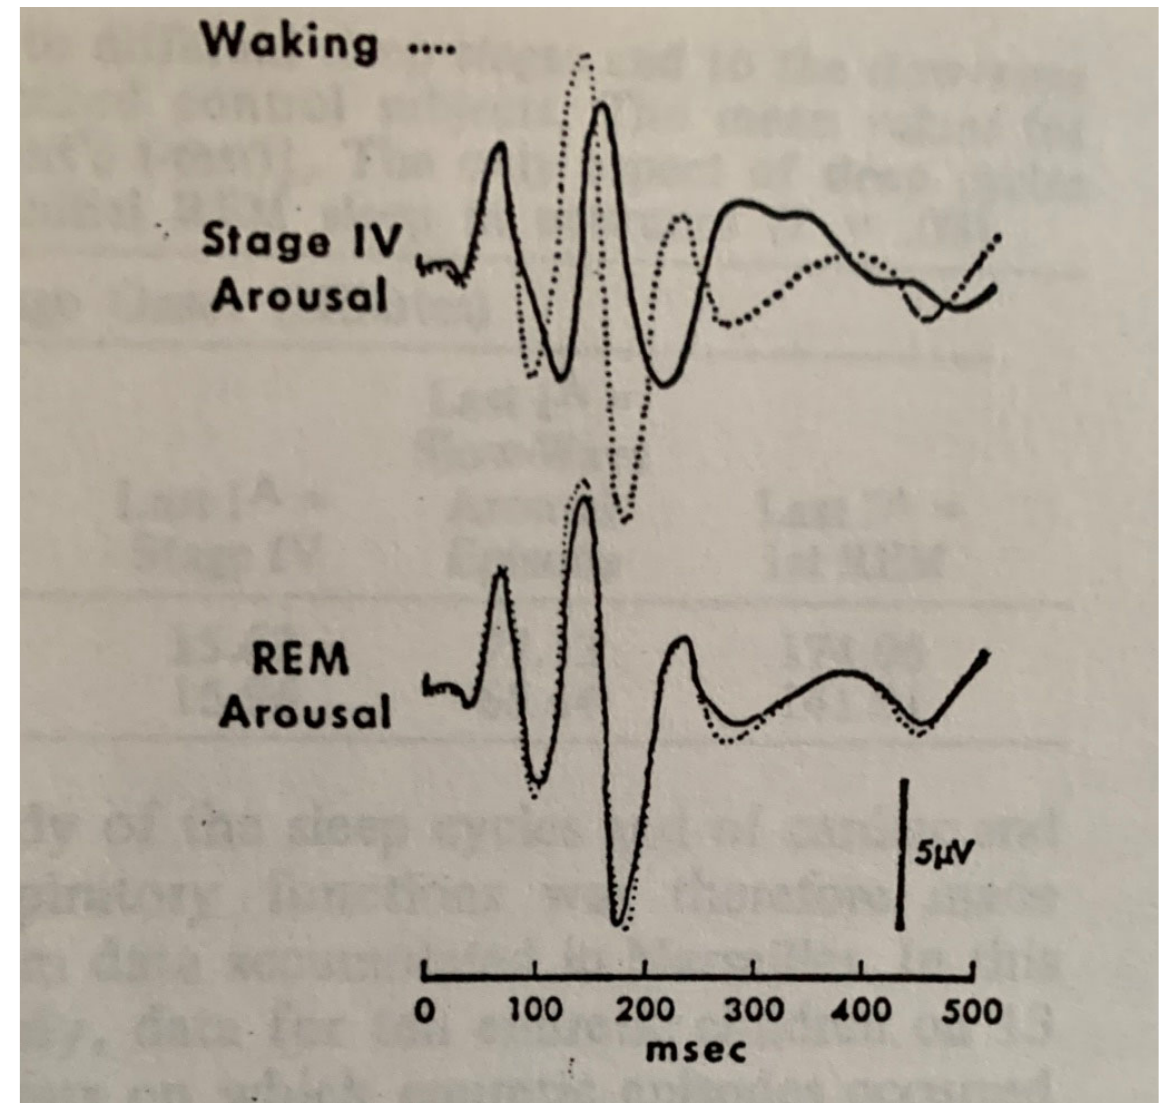
Figure 13. Visual evoked potentials in presleep wakefulness (dotted line) and after arousal in slow ‐ wave sleep and REM sleep. After slow wave sleep arousals the VEP components are somewhat delayed and the amplitude is decreased. After REM sleep arousals the VEP is immediately essen ‐ tially identical to that of pre ‐ sleep wakefulness. (Reproduced with permission from Broughton R. identical to that of pre-sleep wakefulness. (Reproduced with permission from Broughton R.